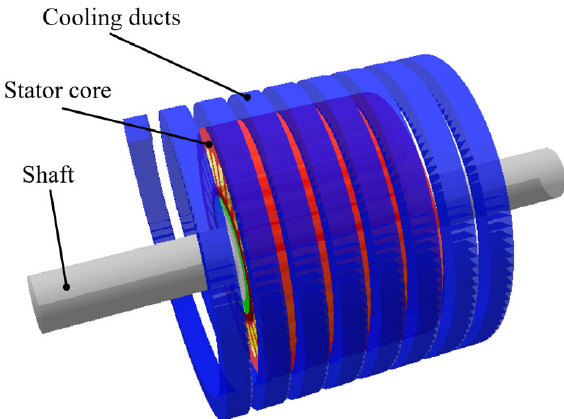
Figure 25. Spiral water ducts for designed motor stator housing cooling system.